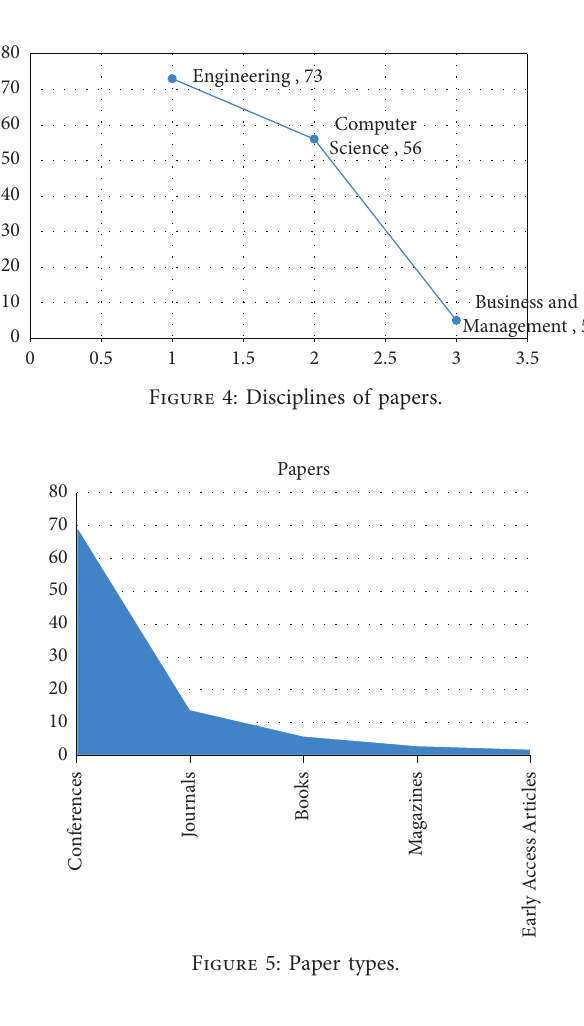
Figure 1: IoT-based health monitoring system.